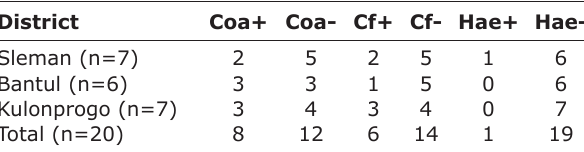
Table-3: Characterization of S. aureus from SCM in PE goats at Yogyakarta.